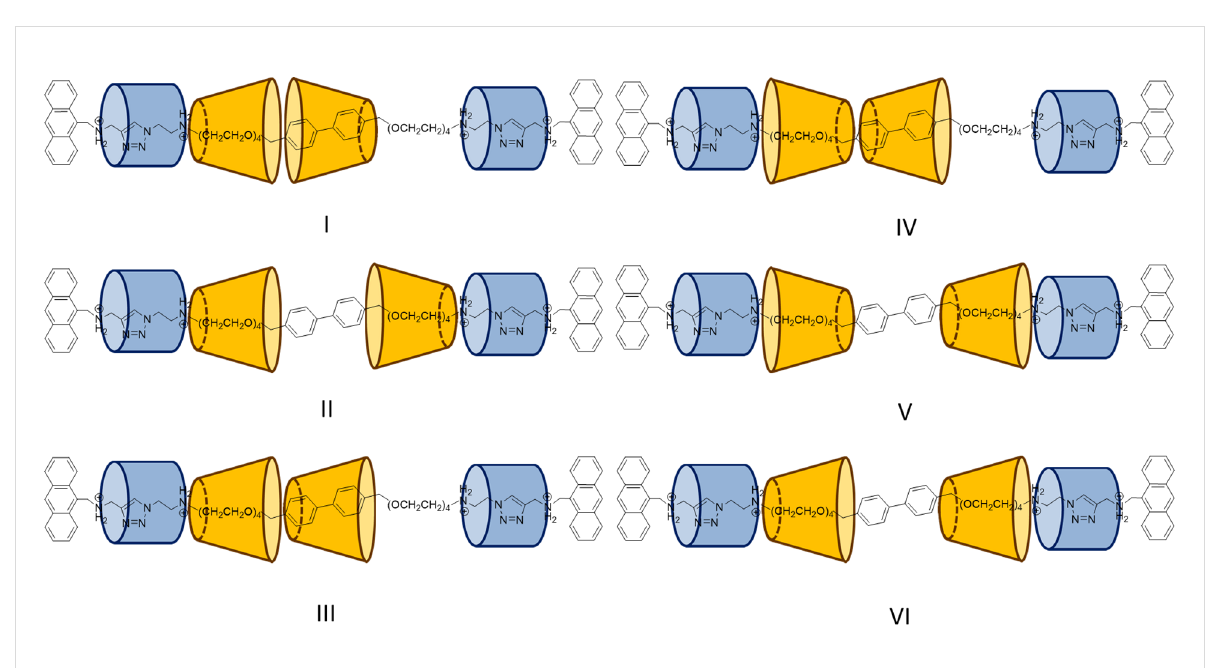
of 5R is also consistent with the two closely eluted peaks in the LC chromatogram. Assuming no fast movement of the two γ -CDs on the axle in 5R as in 4R , there could be six different possible isomers for 5R , and if any γ -CD interlocking at the tetra(ethylene glycol) part is interacting with the CB[6] via its primary face just as in 4R and 6R , three of the six possible isomers (IV, V and VI) will be eliminated (Figure 5). If it is further assumed that the γ -CD on the biphenylene has no influ- ence on the symmetry of the triazole and CB[6] as discussed above, isomers I and III will both give two sets, whereas the symmetrical isomer II will give one set of triazole and CB[6] signals. The NOESY spectrum of 5R may not provide further information due to the complexity of the spectrum (Figure S14 in Supporting Information File 1), and further structural assign- ment of 5R may not be straightforward unless more detailed structural characterization such as X-ray crystal data is avail- able. Nevertheless, the observation that 5R was obtained as dif- ferent stereoisomers further strengthens the proposal that it is the full occupancy of the axle by the macrocycles in 6R that results in a cooperative interaction so that the formation of 6R is stereoselective. With one less γ -CD in 5R , interactions be- tween the axle and the macrocycles alone are only enough for interlocking the macrocycle, but not sufficient to drive a specif- ic orientation of all the γ -CD, suggesting intercomponent stabi- lization could play an important role in directing higher level structures in mechanically interlocked molecules, reminiscent to the intra-strands interactions that stabilize high-order structures in